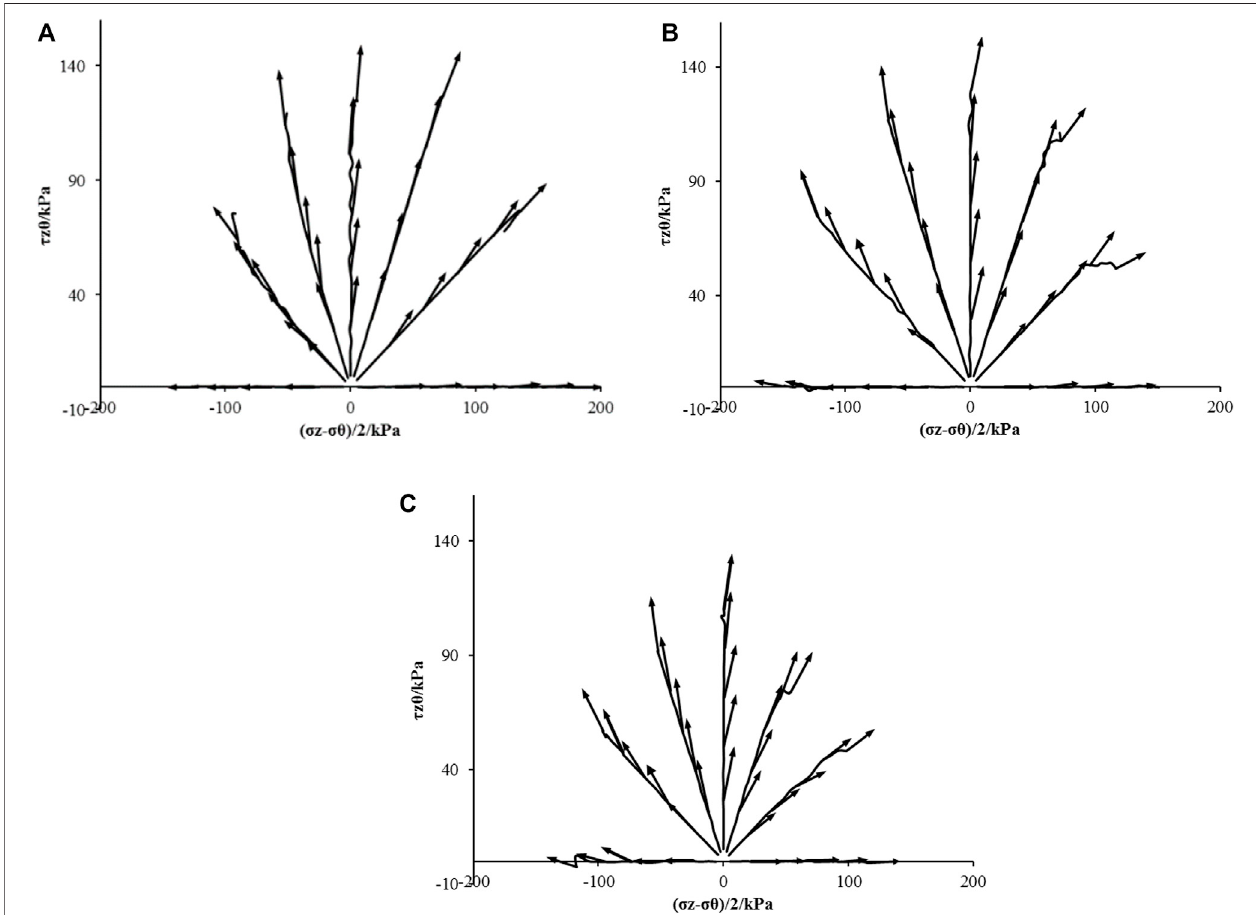
FIGURE 9 | The non-coaxial characteristics of the remolded loess in the deviatoric plane: (A) b = 0; (B) b = 0.5; (C) b = 1